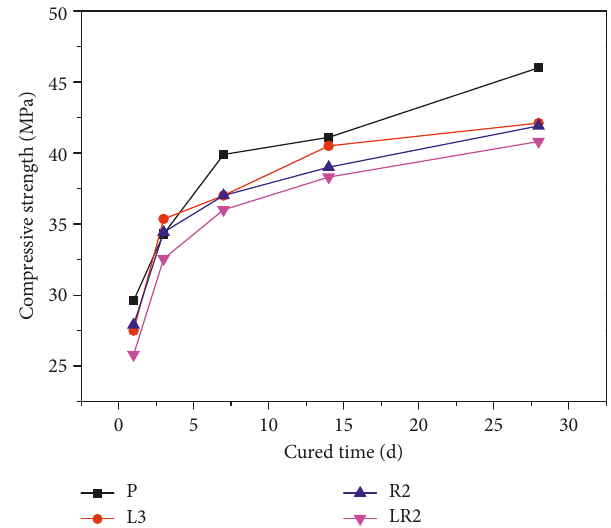
Figure 9: Compressive strength of cement slurry with curing time.